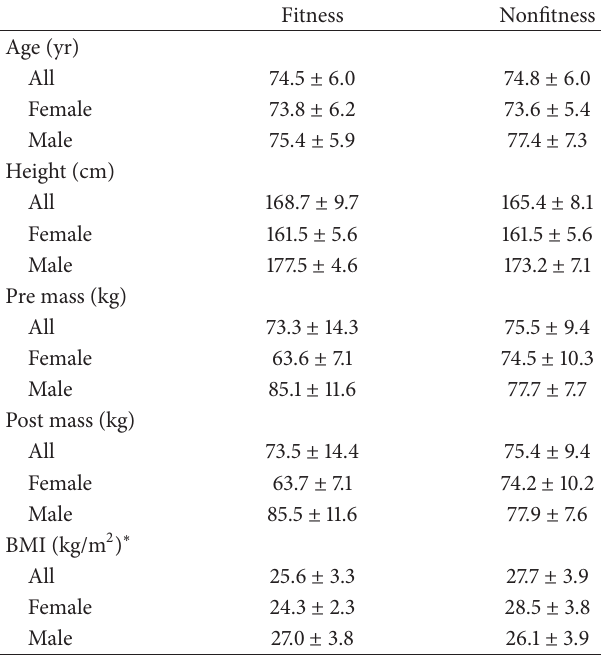
Table2:Correlationtable( 𝑟 2 values)oftotalweeklystepsandLPAQ MET levels for all subjects and each